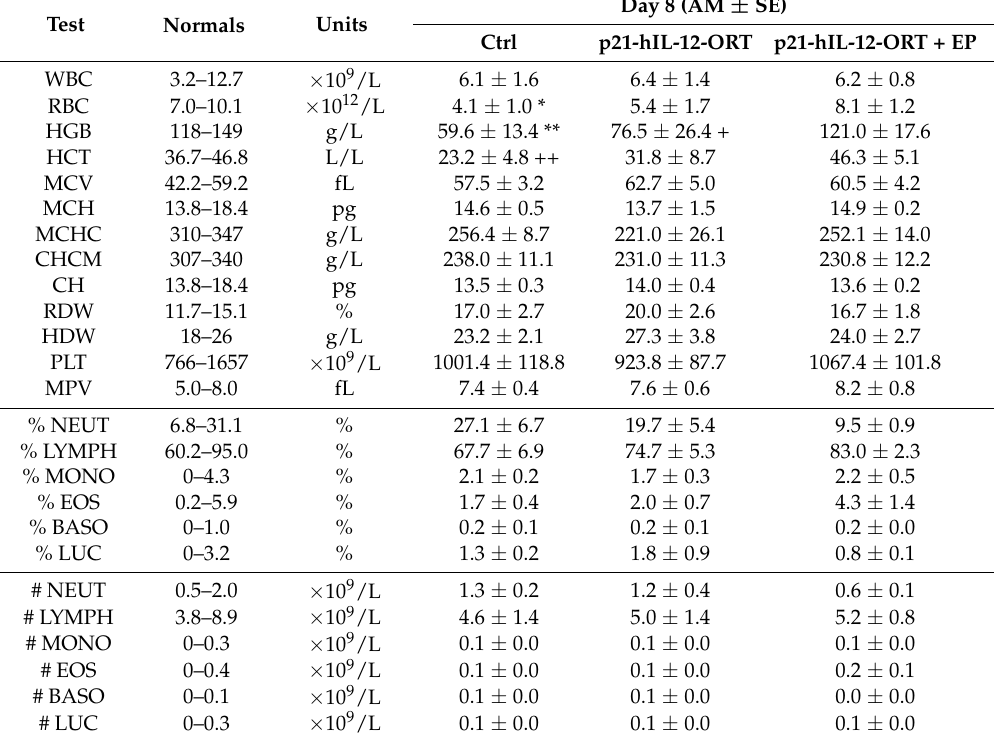
Table 1. Blood hematology 8 days after p21-hIL-12-ORT GET to B16F10 mouse melanoma